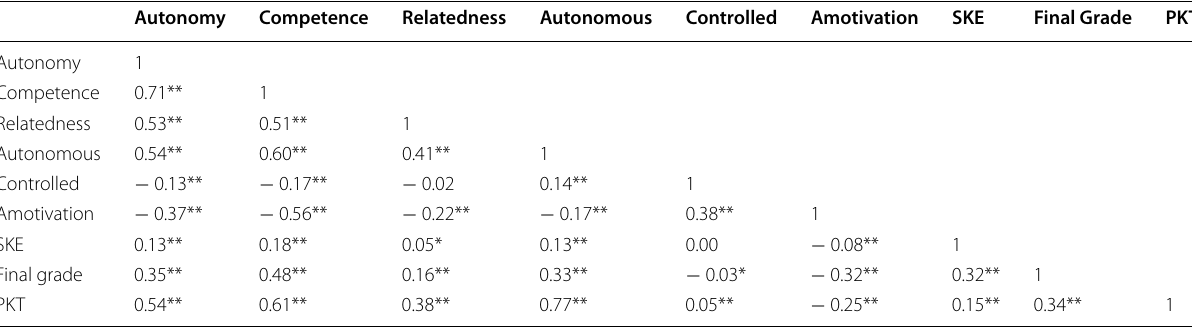
Table 1 Correlation among the